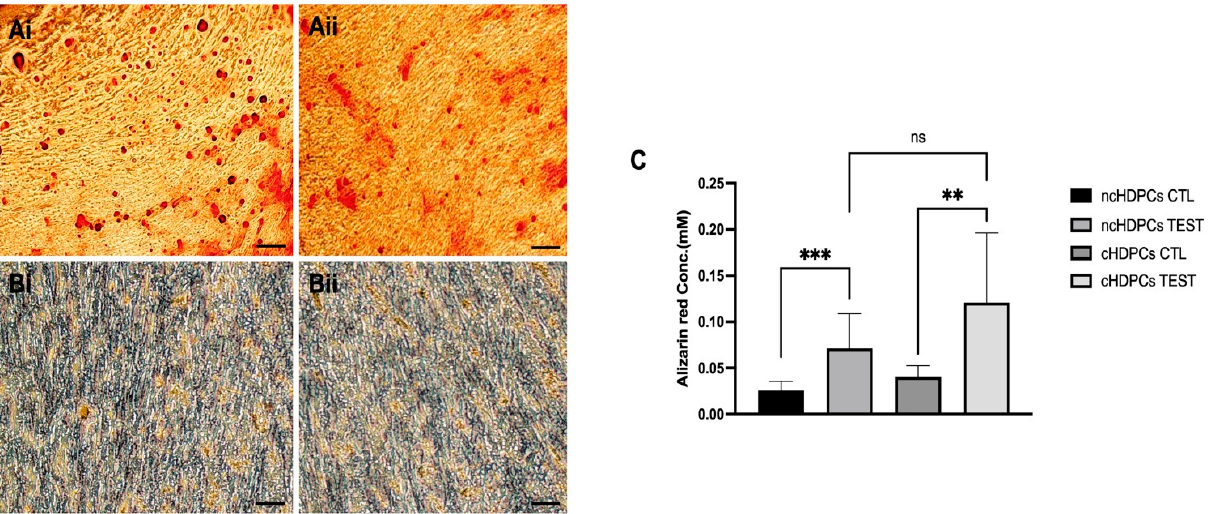
Figure 3. Representative photomicrographs of ncHDPC ( Ai ) and cHDPC ( Aii ) cultures after Alizarin red S- staining showing in red the presence of calcium deposits within the background of differentiated dental pulp cells on day 21 of culture in mineralizing media. Cultures of ncHDPCs ( Bi ) and cHDPCs ( Bii ) in standard unsupplemented culture media, which served as controls. Scale bar = 200 µm. ( C ) Quantification of Alizarin red S- stain in cultures of ncHDPCs and cHDPCs (n = 5 each) (TEST and CTL/CONTROL represent HDPCs cultured with or without mineralizing media for up to 21 days, respectively). A significant difference was found between ncHDPC test and control cultures (*** p = 0.0004), and there was a similarly outcome for cHDPC test and control cultures (** p = 0.0048). No significant difference (ns) was found between mineralization levels in ncHDPC and cHDPC test cultures ( p = 0.18). Error bars indicate mean ± SD.